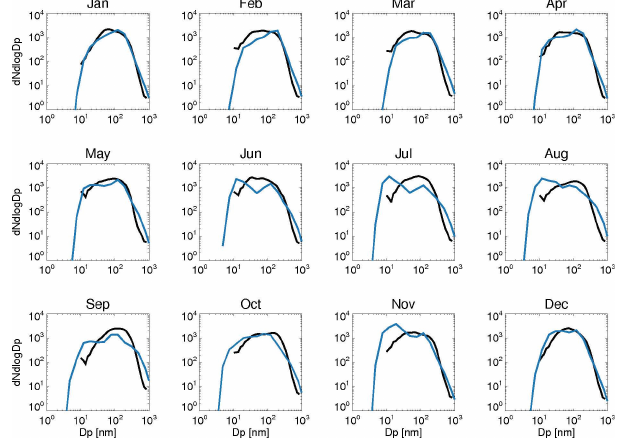
Fig. 4. Monthly median observed (black) and simulated (blue) par- ticle size